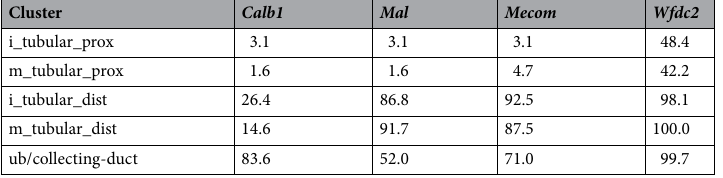
Table 2. Ureteric bud / collecting duct lineage genes are expressed in distal tubular cells. Shown is the percentage of cells expressing ureteric bud / collecting duct (ub/cd) lineage marker genes Calb1 , Mal , Mecom and Wfdc2 for cells from immature and mature distal and proximal tubular clusters, and also from the ub/ cd cluster. In the tubular distal lineage, in contrast to the proximal lineage, a significant fraction of cells expresses these four ureteric bud/collecting duct marker